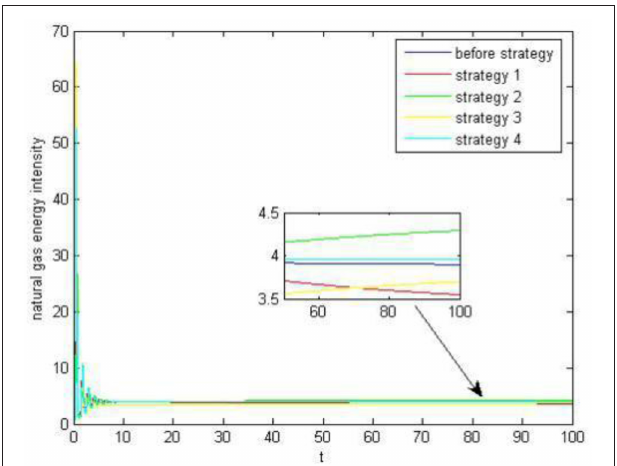
FIGURE 11 | Natural gas energy intensity